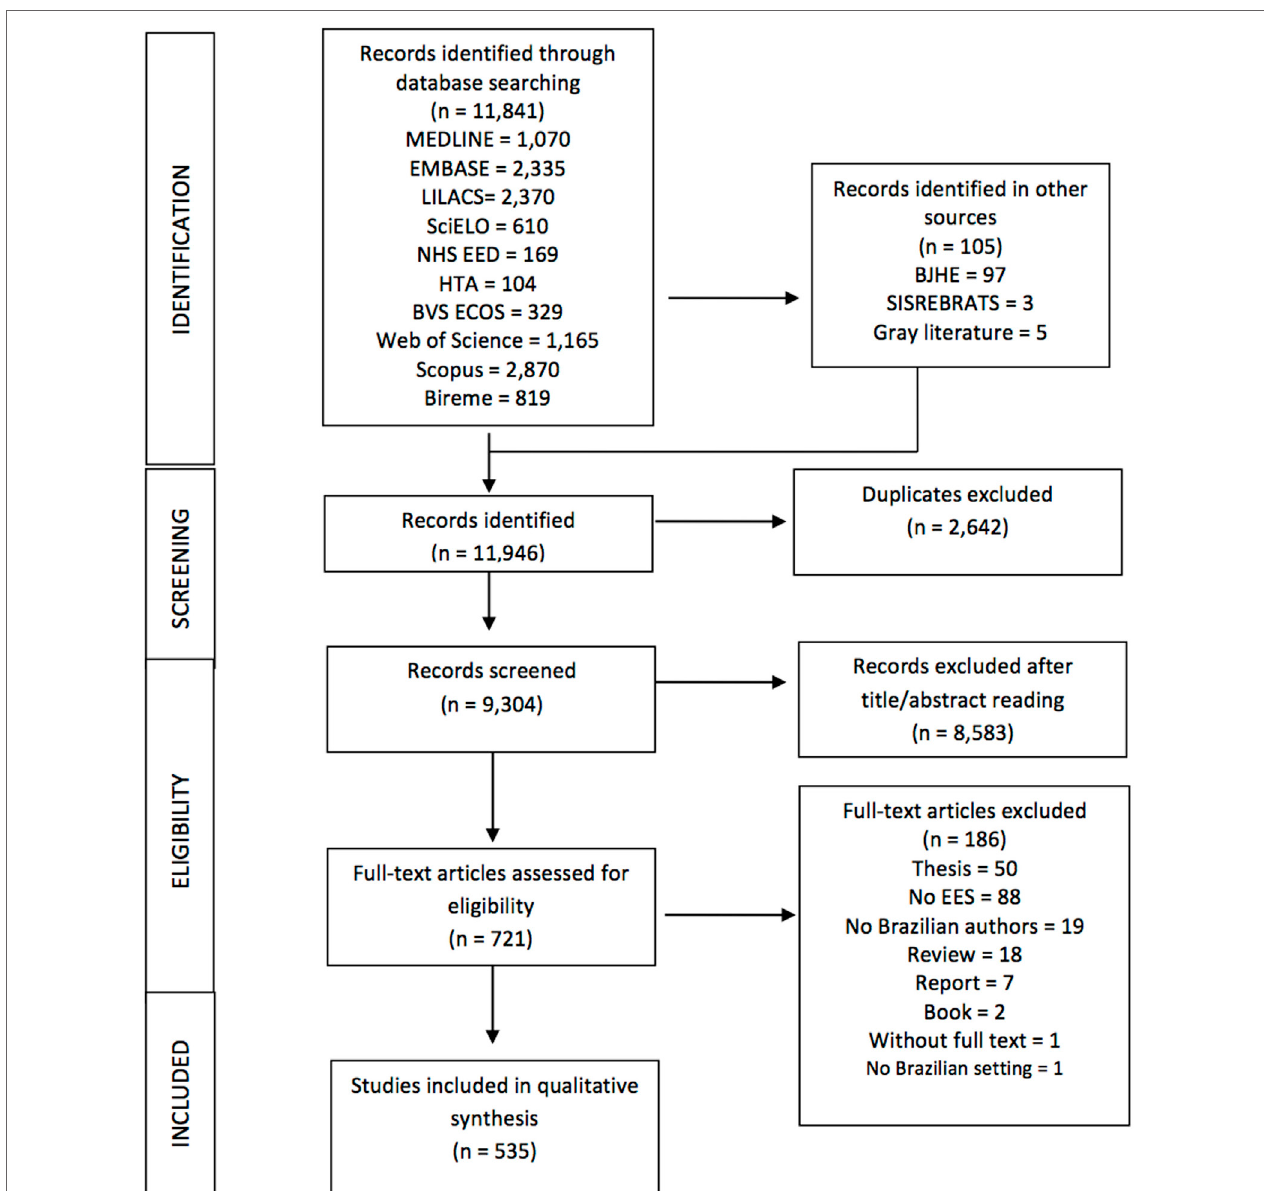
FiGURe 1 | Flow diagram of health economic evaluation studies in Brazil,